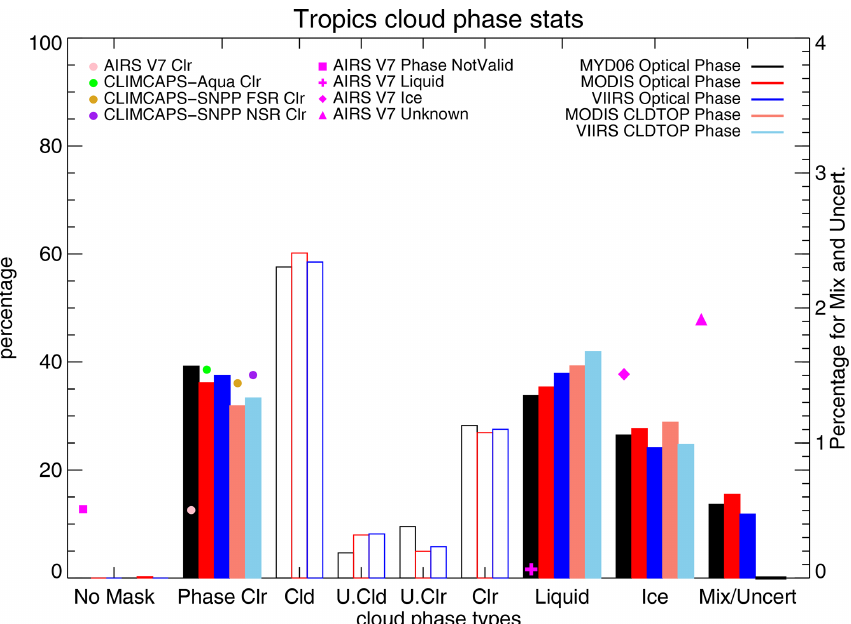
Figure 15. The histograms of cloud thermodynamic phases (solid color bars) and cloud mask (hollow color bars) in the tropics (30 ◦ N–30 ◦ S) from the imager cloud products calculated using retrievals on SNOs from the 7 focus days. The frequency of clear sky detected by IR sounders using thresholds of ECF < 0 . 01 is also shown by colored solid circles. AIRS version 7 cloud thermodynamic phase is shown by magenta symbols. Color of the bars corresponds with different imager cloud retrievals for cloud mask and cloud thermodynamic phase determined in the optical-property retrieval (Cloud_Phase_Optical_Properties): black for MYD06, red for Aqua MODIS continuity products (CLD- PROP_MODIS), and blue for SNPP VIIRS continuity products (CLDPROP_VIIRS), respectively. The Cloud_Phase_Optical_Properties variable reports flags indicating cloud mask not determined for pixel (No Mask), clear sky (Phase Clr), liquid water cloud (Liquid), ice cloud (Ice), or undetermined phase (Mix/Uncert). Cloud phases reported by Cloud_Phase_Cloud_Top_Properties in the MODIS–VIIRS continuity cloud products are also evaluated, and results are shown with pink (MODIS) and light-blue (VIIRS) bars, which show flags indicating cloud free (Phase Clr), water cloud (Liquid), ice cloud (Ice), or mixed-phase cloud or undetermined phase (Mix/Uncert). Note that the mixed-phase cloud or undetermined phase (Mix/Uncert) category for imager products is shown with the y axis on the right due to its much smaller fre- quency of occurrence. Cloud mask histograms of not determined (No Mask), cloudy (Cld), uncertain (U. Cld), probably clear (U. Clr), and confidently clear (Clr) are shown in the figure following this color convention but using hollow bars. For IR sounder clear-sky frequency, re- sults from AIRS V7 (pink), CLIMCAPS-Aqua (green), CLIMCAPS-SNPP FSR (yellow), and CLIMCAPS-SNPP NSR (purple) are overlaid on top of the clear-sky (Phase Clr) histograms for sounder–imager clear-sky detection comparison.